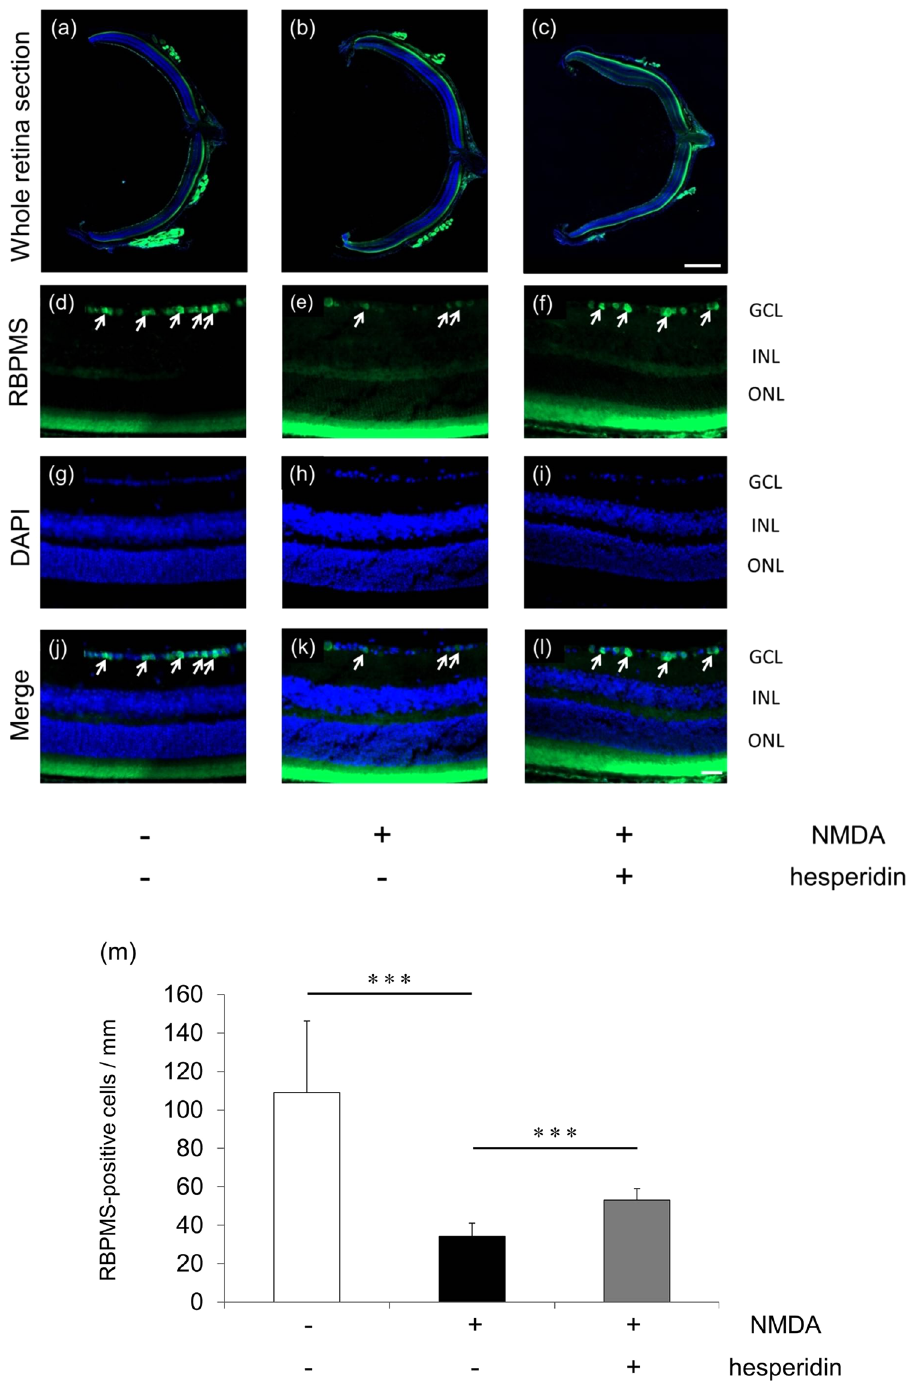
Figure 3. Hesperidin treatment preserved RGC marker-positive cells after NMDA injury. Representative photographs at lower ( a – c ) and higher ( d – l ) magnification with nuclear staining (DAPI) and immunostaining with anti-RBPMS antibody, taken 24 h after intravitreal injection with PBS ( a , d , g , j ), 30 nmol NMDA ( b , e , h , k ), or NMDA with hesperidin ( c , f , i , l ). RBPMS-positive cells in the GCL are shown by the arrows. ( m ) Histogram showing the average number of RBPMS-positive cells in the retinas. Data represent mean ± SD, (vehicle, n = 6, NMDA, n = 8, NMDA with hesperidin, n = 7) *** p < 0.001. A-C scale bar: 500 µ m, D-L scale bar: 50 µ m. GCL; ganglion cell layer, INL; inner nuclear layer, ONL; outer nuclear